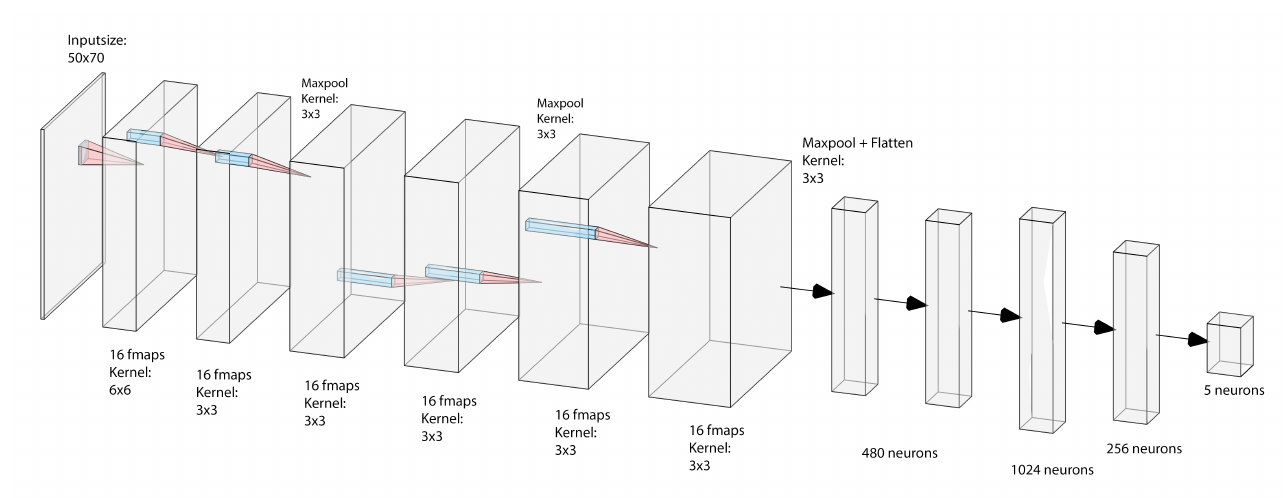
Figure 2. The structure of the neural network. Features generated by 6 convolutional layers are flatted and serve as input to 2 LSTM layers and 3 dense layers, including the output